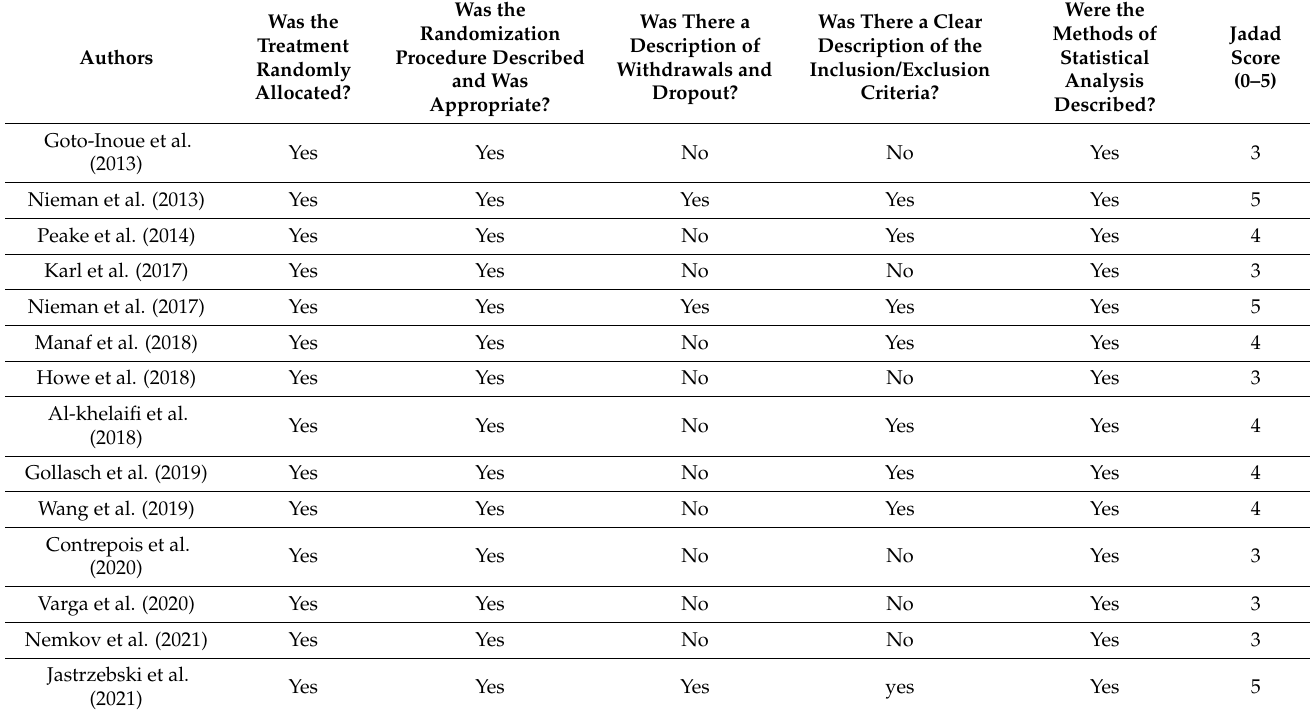
Table 2. The modified Oxford quality